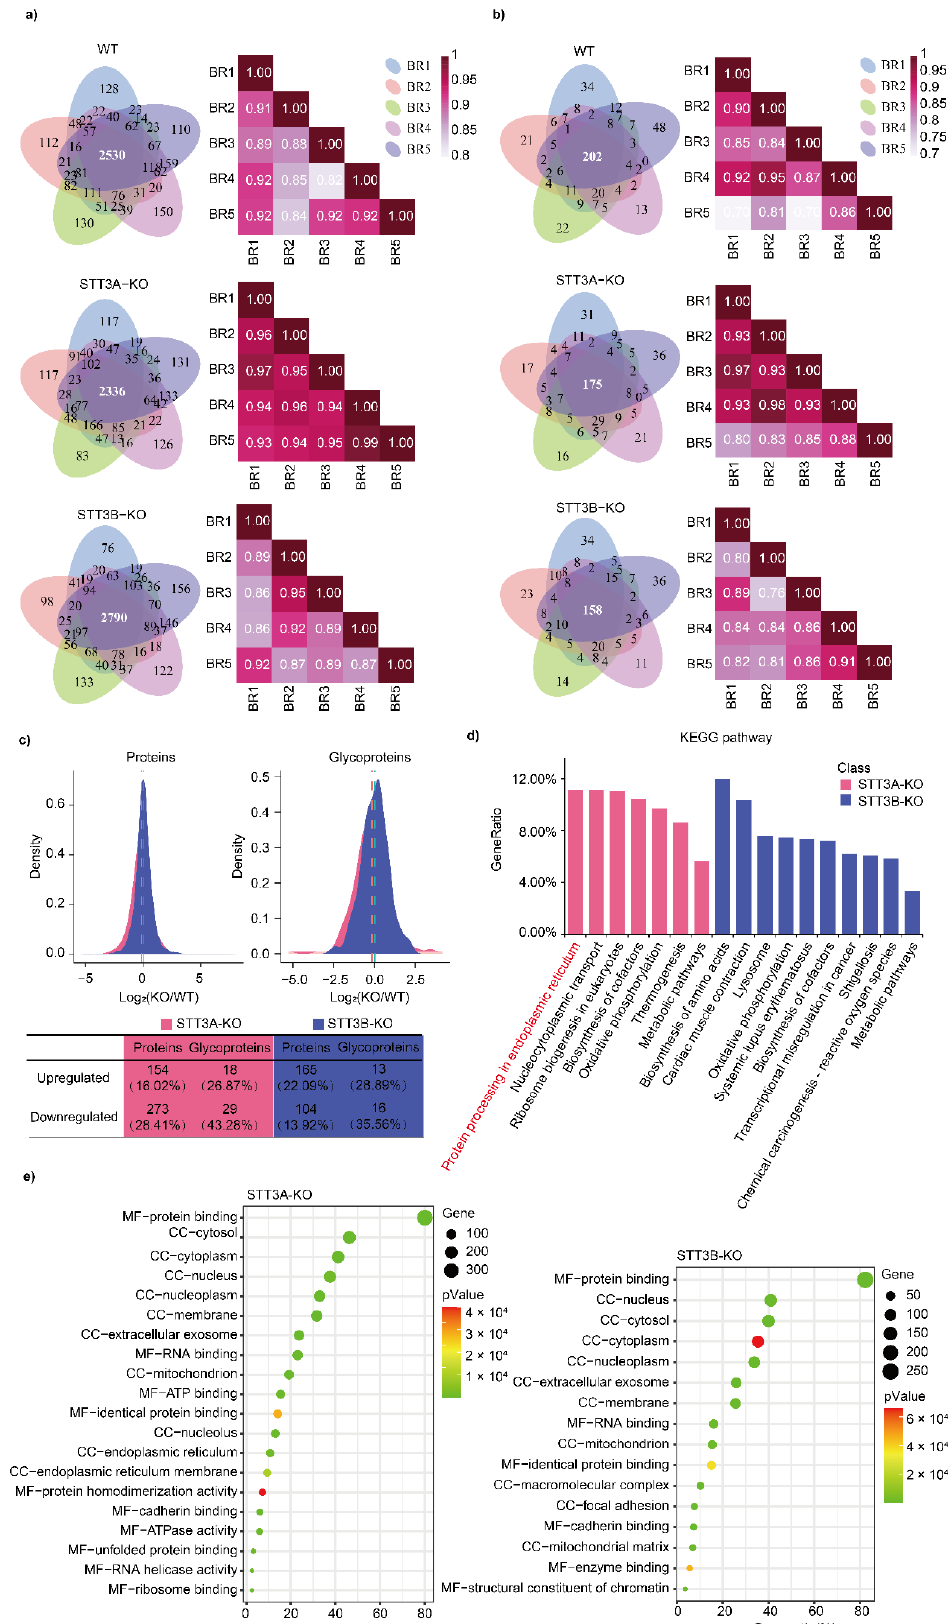
Figure 1. Identification and functional classification of proteins in STT3A-KO and STT3B-KO cells compared to wild-type (WT) HEK293 cells. Overlapping and Pearson’s correlation relationship